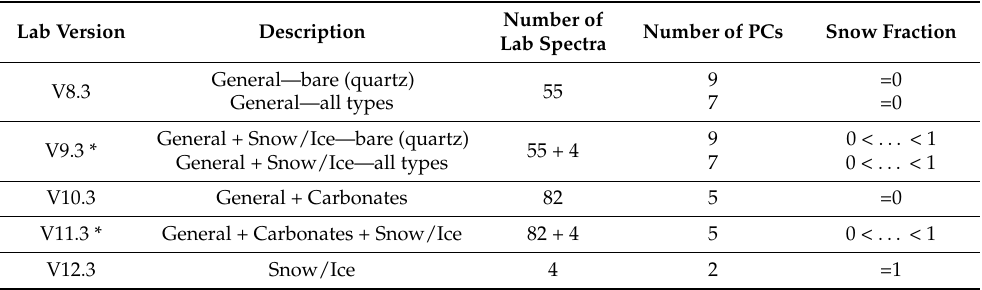
Table 1. Laboratory datasets of spectral emissivity used in the Combined ASTER MODIS Emissivity Over Land (CAMEL)